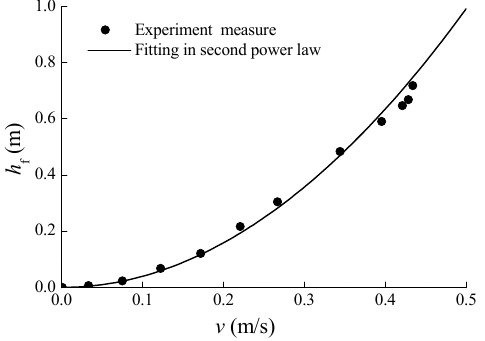
Figure 4. Measurement of hydraulic head loss in steady flow.